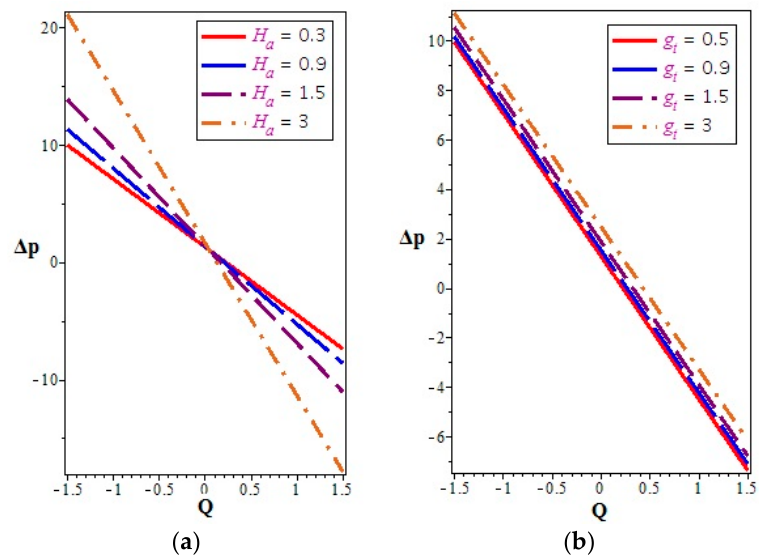
p Δ Figure 8. Pressure rise ∆ p versus volume flow rate Q for di ff erent values of: ( a ) H a , and ( b ) g t , keeping Figure 8. Pressure rise versus volume flow rate Q for different values of: ( a ) other parameters fixed as g c = 0.5, S r = 0.5, S c = 0.1, β = 0.4, ε = 0.3, and δ = g , keeping other parameters fixed as 0.5, g = t c δ= and 0.3 .